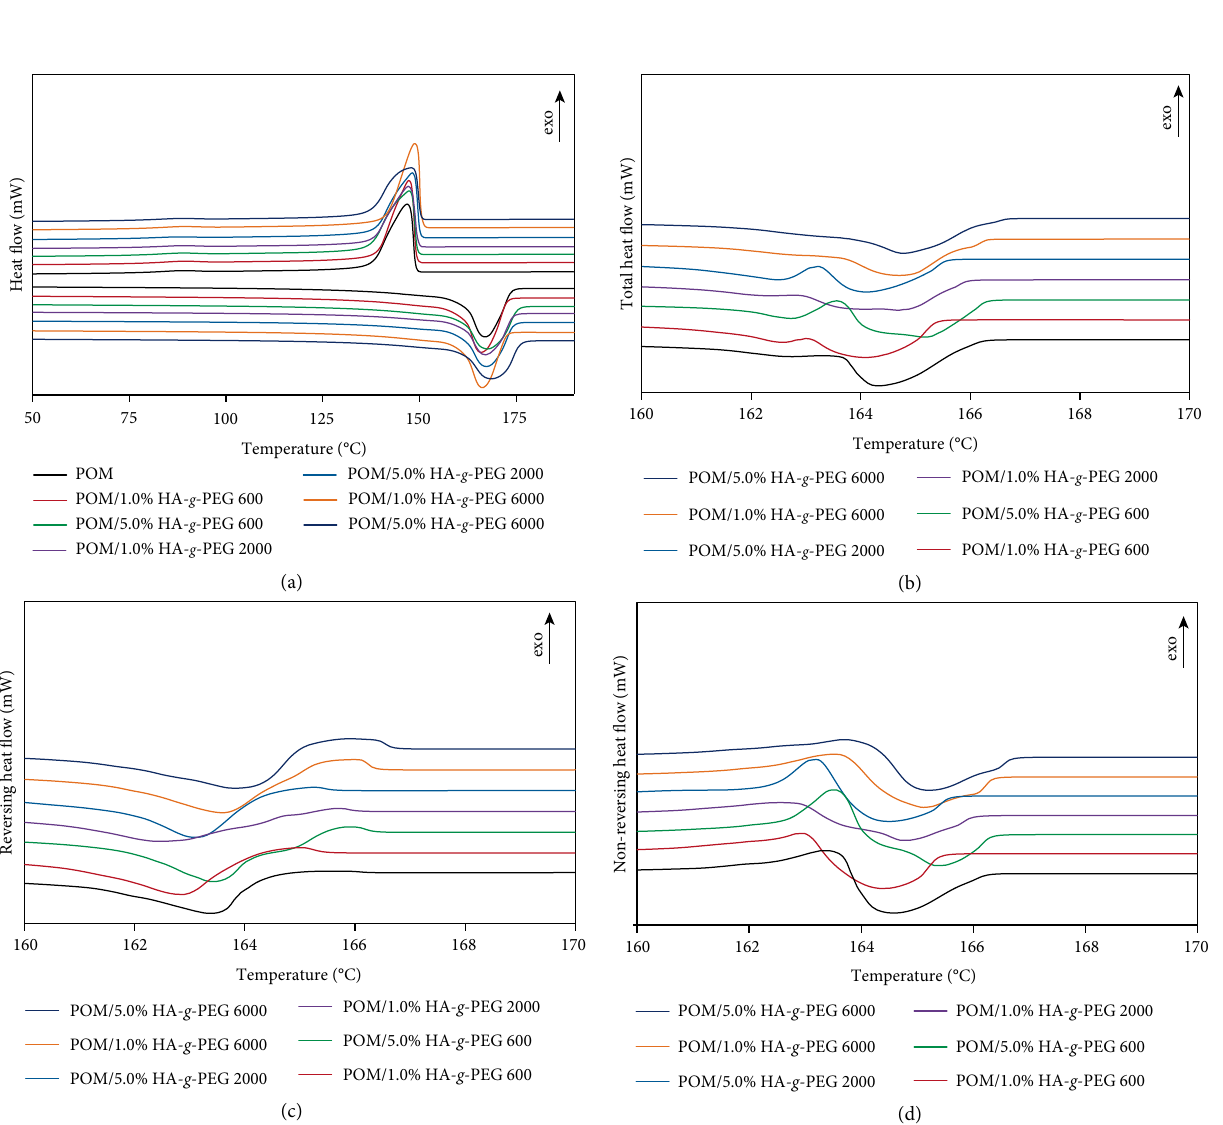
Figure 4: DSC curves (a) (the second heating run) and TOPEM-DSC profiles (b–d) of POM/HA- g -PEG